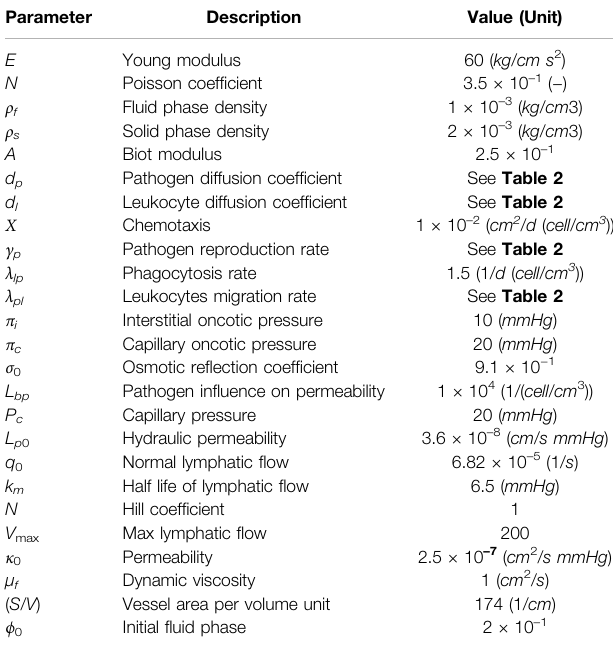
TABLE 1 | Reference parameters values used for experiments in Section 3